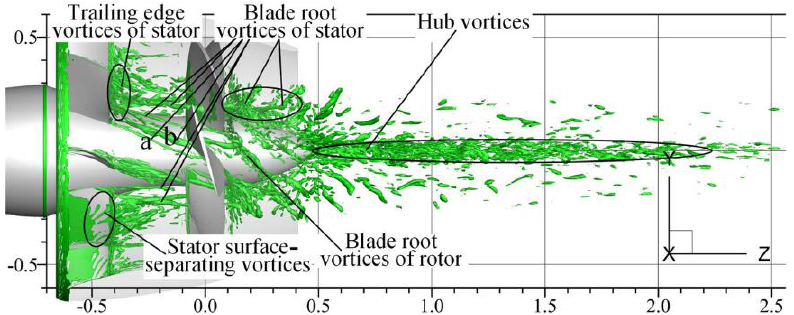
Figure 11. Coherent structures of vortices in the wakes of the stator, rotor, and hub [15].